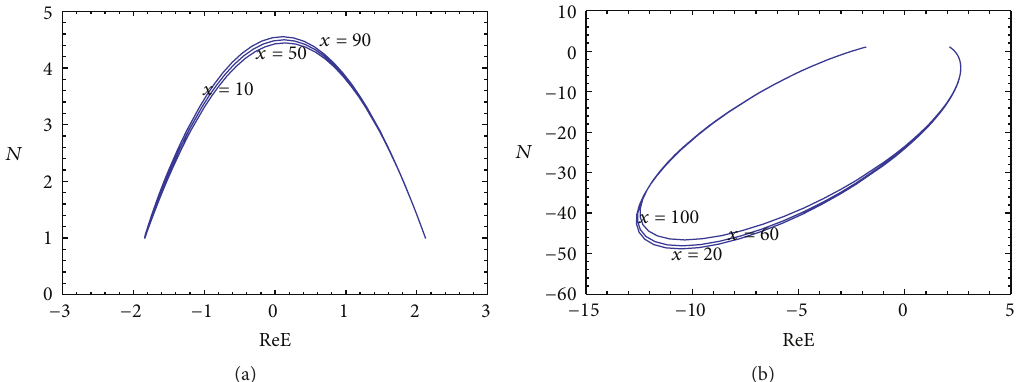
Figure 4: Arc Heteroclinic orbit for Schr¨odinger-Boussinesq equation as 𝑡 → ±∞ at 𝑥 = 10 ∗ (2𝑘 + 1) (a) and 𝑥 = 10 ∗ (4𝑘 + 2) (b), where 𝑘 = 0,1, 2, .. .